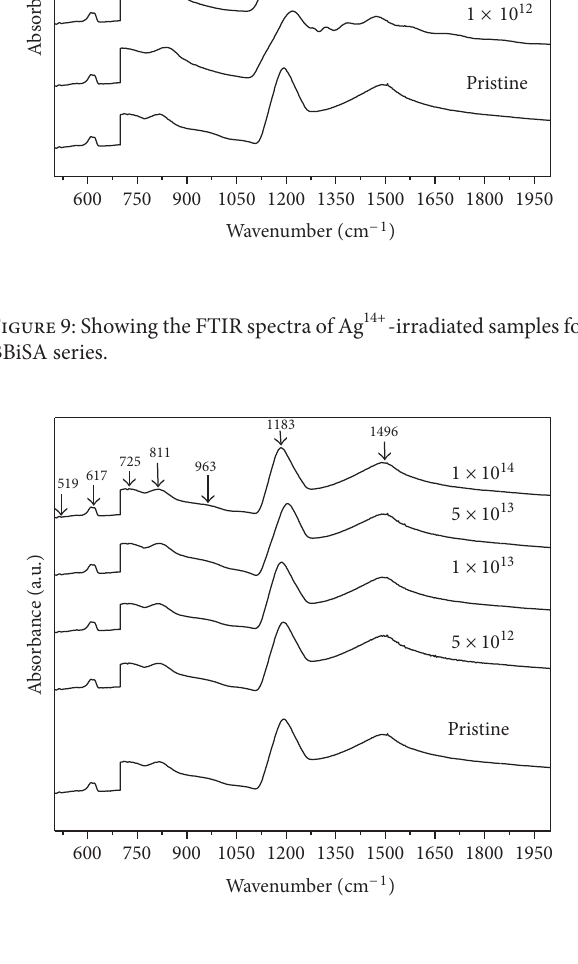
-irradiated samples for 3+